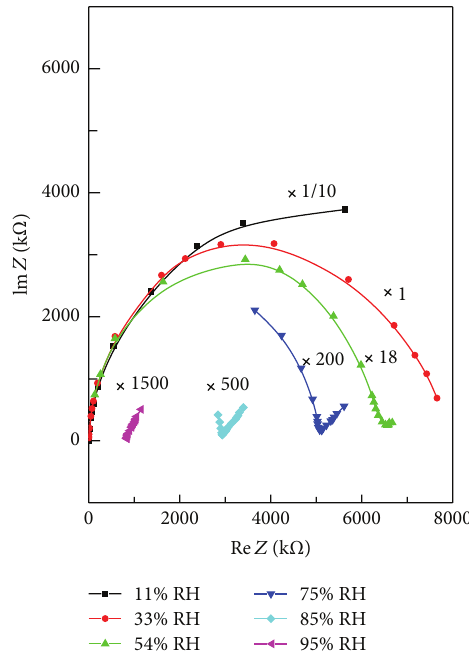
Figure 8: Complex impedance plots in wide humidity environ-